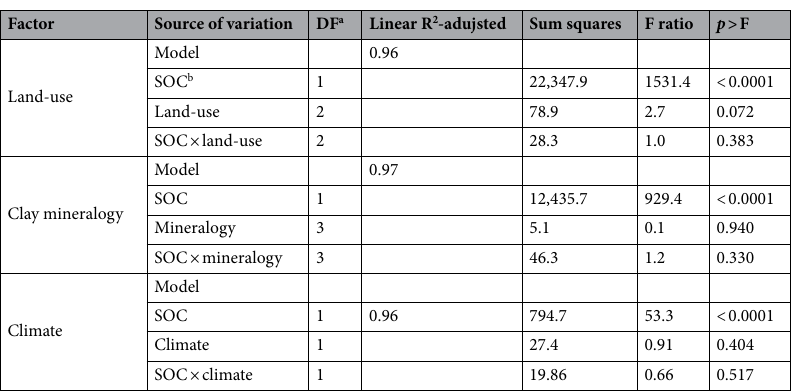
(cid:31) β C ) of Eq. (1) (see “Methods”